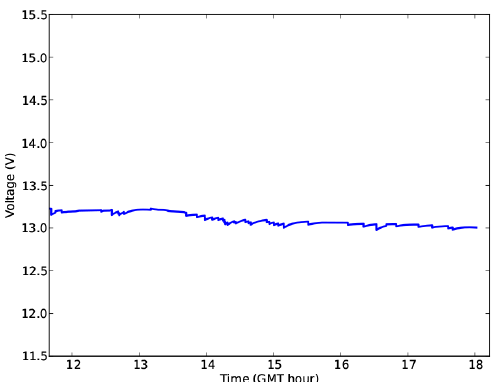
Figure 17. Evolution of internal battery charge using a 10W solar